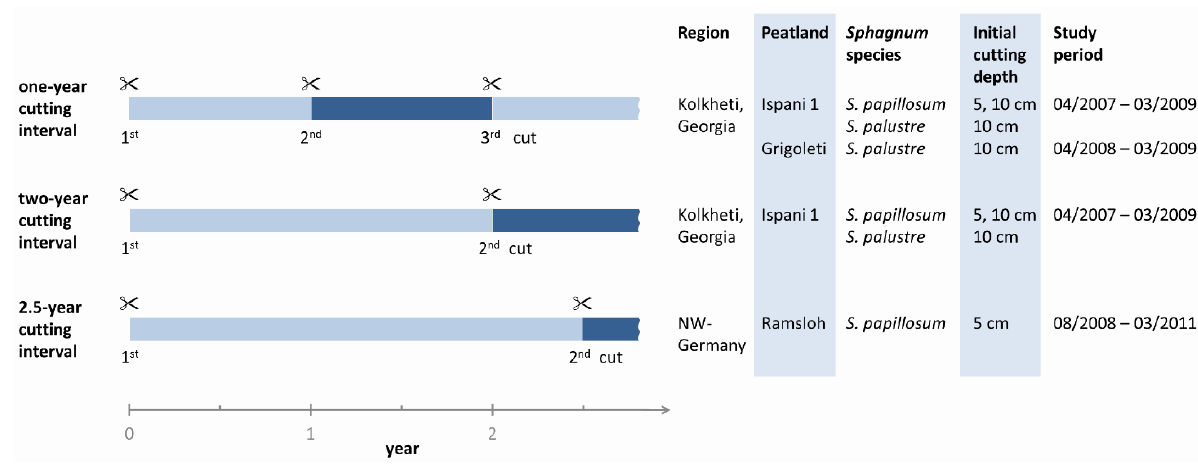
Figure 2. Overview of the study treatments ( Sphagnum species, initial cutting depth and cutting interval), peatlands and